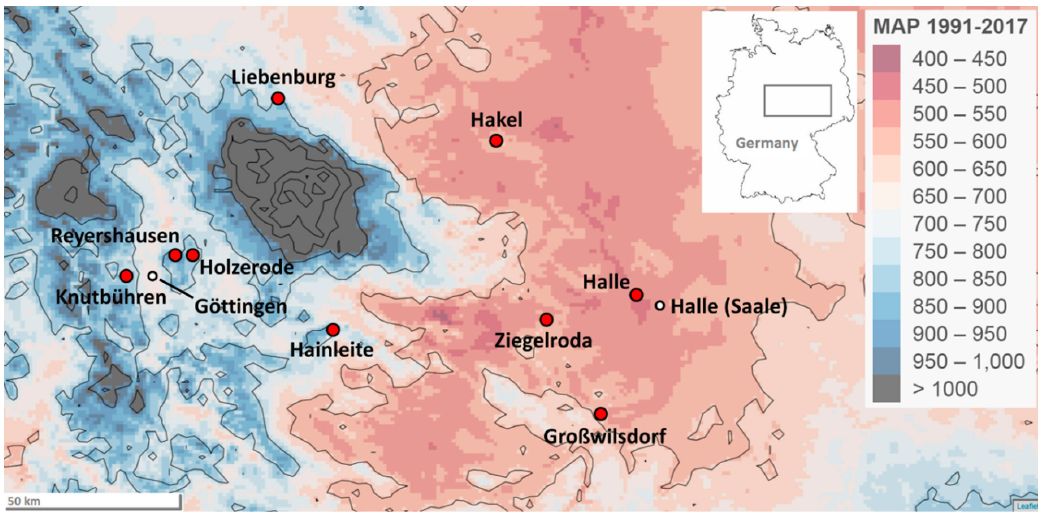
Figure 1. Map of the study area between Göttingen and Halle/S. in central Germany with the precipitation gradient from the west to the east. The nine study sites are marked with red dots. The colors indicate the mean annual precipitation (MAP 1991–2017). The area with MAP over 1000 mm NE of Göttingen is the Harz mountain range.